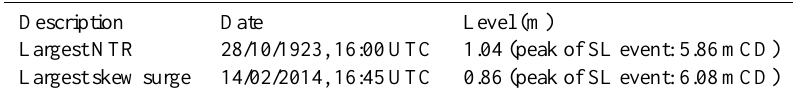
Table 1c. Extreme storm surges and high tide at Newlyn (CD refers to “chart datum”; 0mCD is approximately the lowest astronomical tide level at each